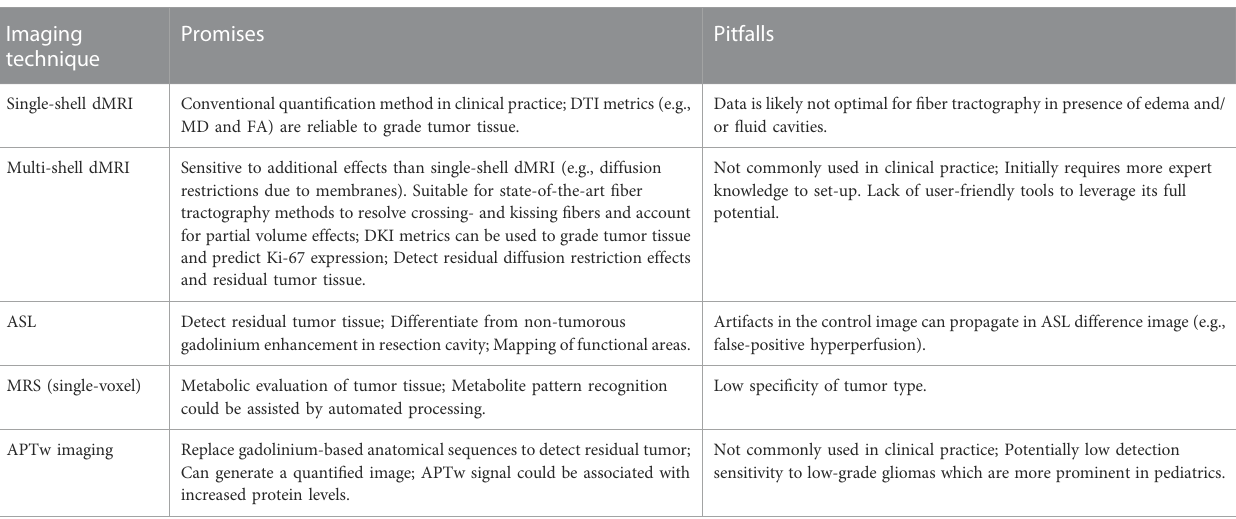
TABLE 4 Clinical implications of advanced ioMRI in